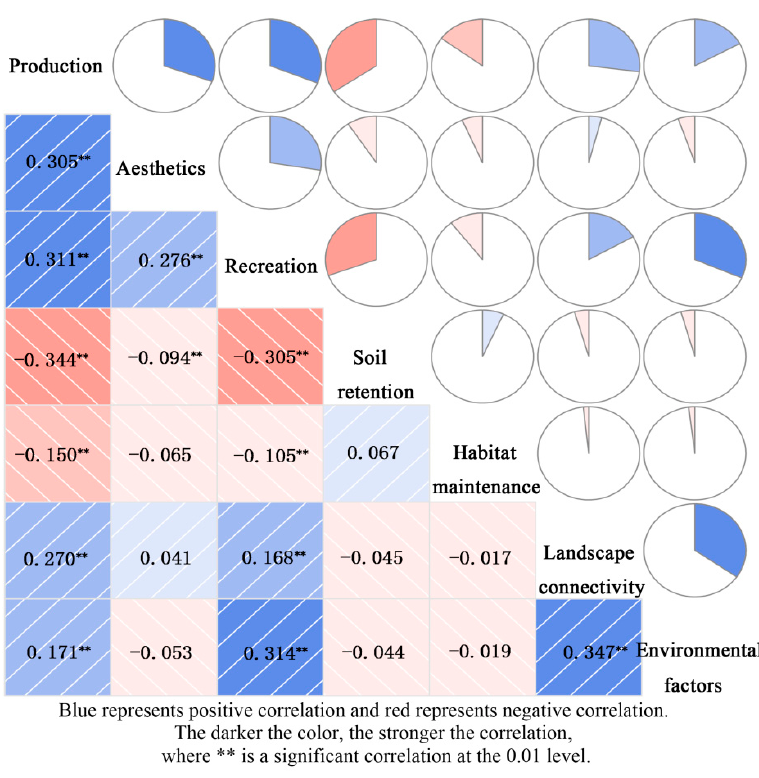
Figure 5. Correlations between farmland functions calculated with Spearman’s rank correlation analysis.